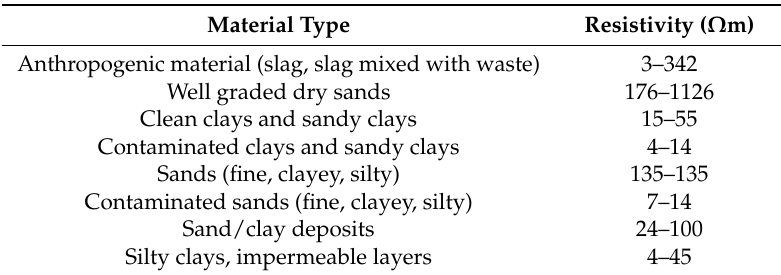
Table 5. Resistivity characteristics of the soil